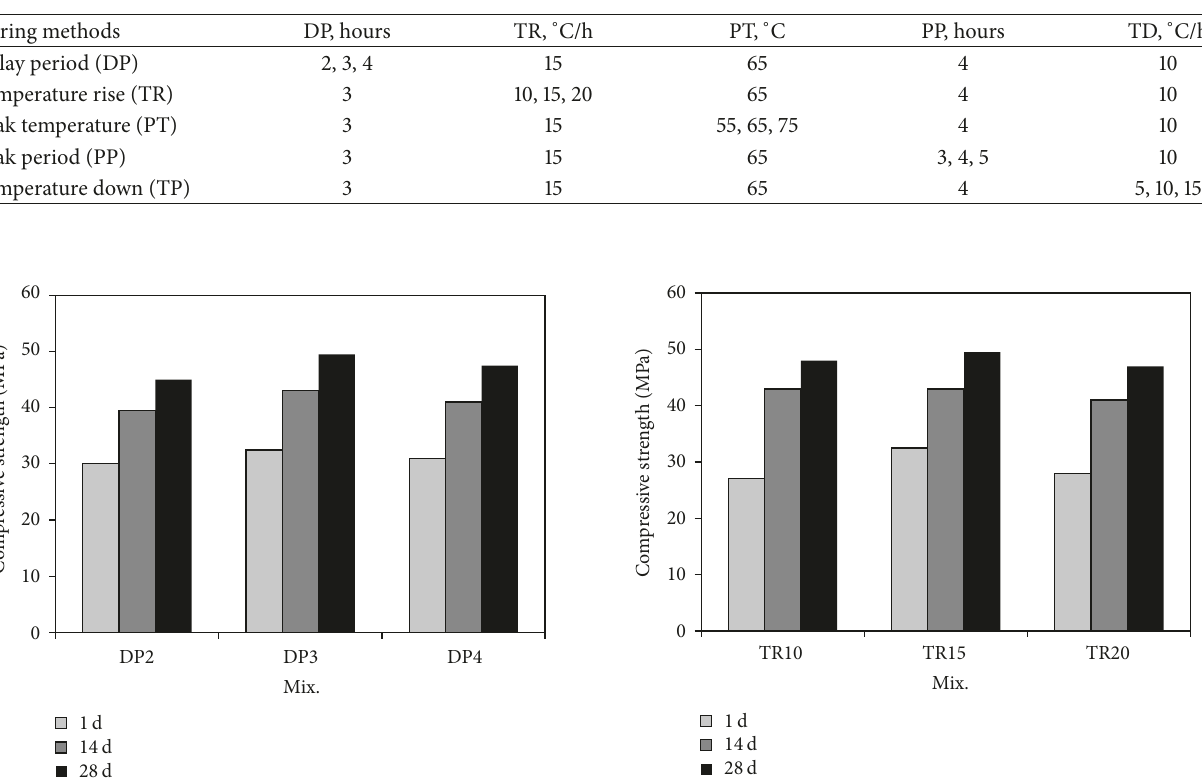
Table 3: Steam curing methods.